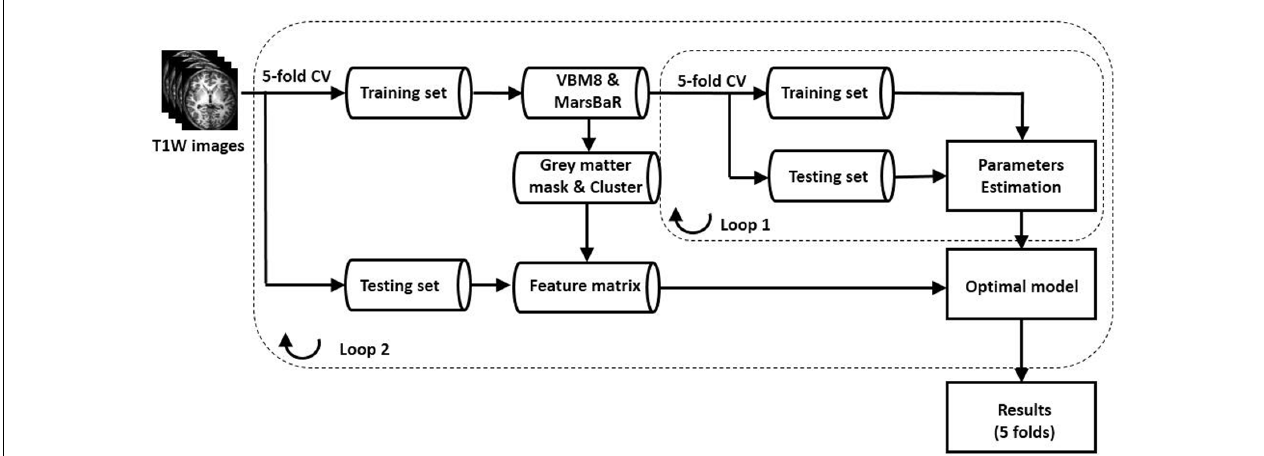
FIGURE 1 | Schematic flowchart of the ML classification model. We used two nested loops to build the classification model. In loop 2, we used fivefold CV method. With fivefold CV, the dataset was randomly split into fivefold, and fourfold were used for training and the remaining onefold for testing. In loop 1, the fourfold training data were divided into five fold, and we performed fivefold CV for calculating the optimized parameters. Note: CV,